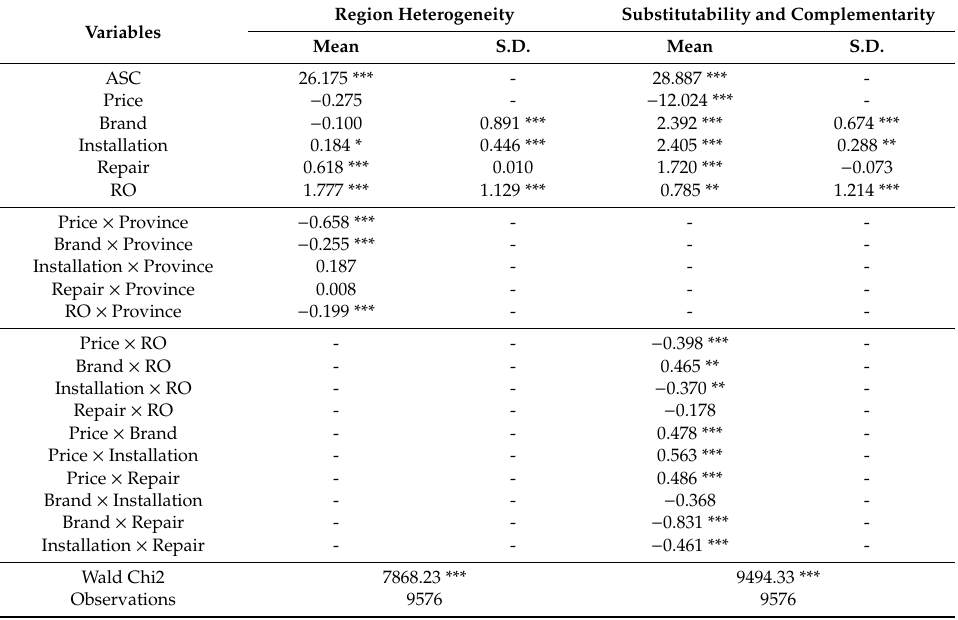
Table 5. The substitutability and complementarity of attributes and region heterogeneity results.